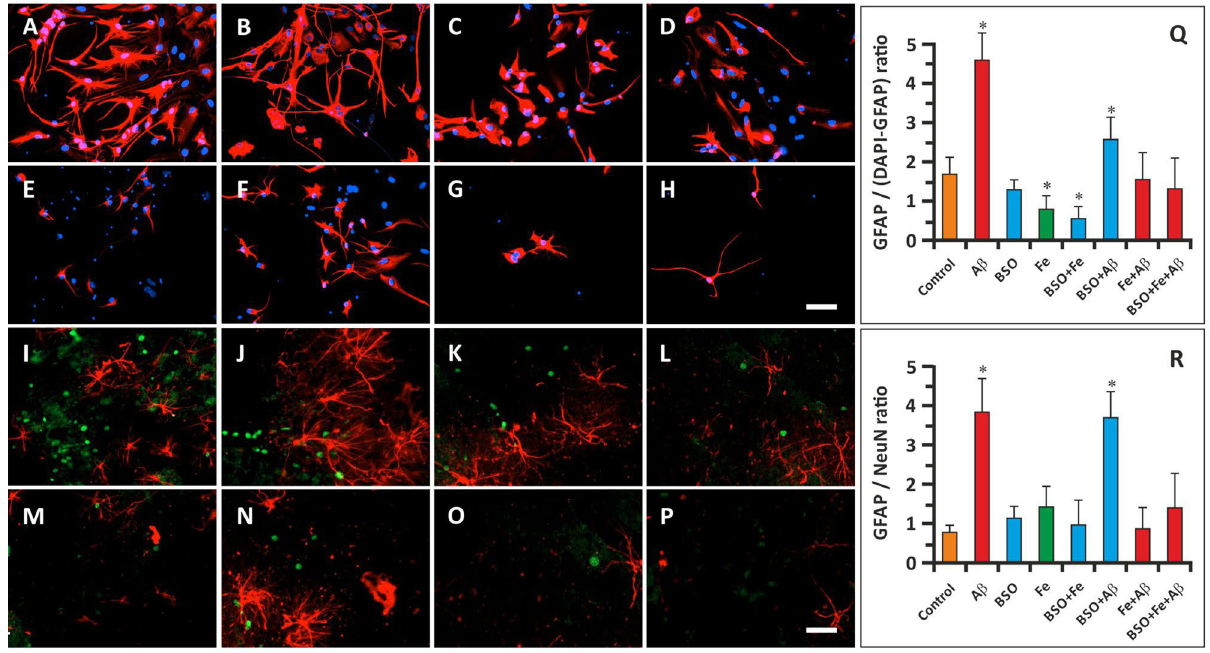
Figure 2. Effect of Aβ, BSO, and Fe 2+ on the ratio of glial cells to neuronal cells and glial and neuronal morphology. ( A – H ) Immunostaining of GFAP (red) and DAPI staining (blue) in hippocampal cells on the 14th day of cultivation. Scale bar, 100 μm. ( I – P ) Immunostaining of GFAP (red) and NeuN staining (green) in hippocampal cells on the 14th day of cultivation. Scale bar, 200 μm. ( Q ) GFAP + /(DAPI + -GFAP + ) cell ratio. ( R ) GFAP + /NeuN + cell ratio. n = 10. * P < 0.05. The error bars indicate the mean ±